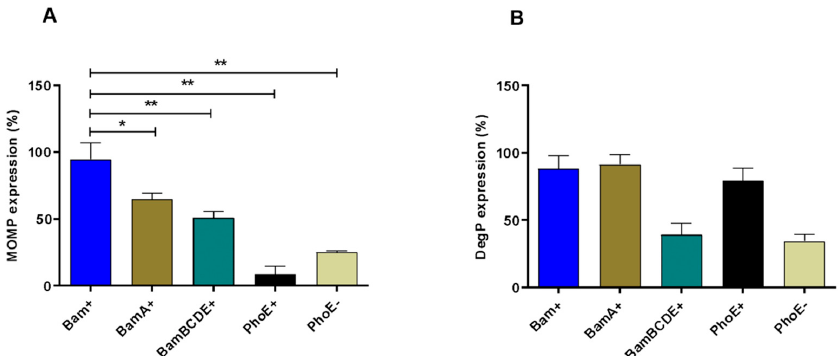
Figure 2. Comparison of Ct -MOMP expression in the presence of the full Bam complex, BamA, or BamBCDE subcomplex. Cells co-expressing Ct -MOMP and either the Bam complex (Bam+), BamA, BamBCDE, or PhoE were analyzed by immunoblotting using antisera against Ct -MOMP, DegP, and RpoB. Quantification of signals from samples displayed in Figure S5, Figure S6 was shown. Ct -MOMP ( A ) and DegP ( B ) expression levels in cells co-expressing BamA, BamBCDE, and PhoE were calculated relative to those of cells co-expressing the Bam complex (Bam+). Quantification of Ct -MOMP and DegP levels was normalized for quantification of RpoB levels in the same sample. Measurements were based on three independent experiments. Statistical differences were calculated using